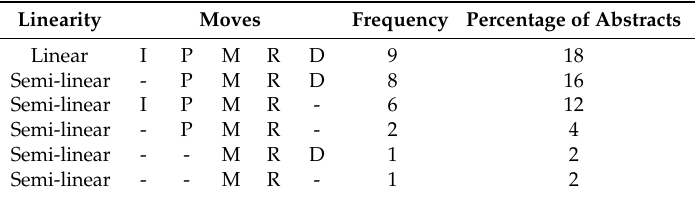
Table 5. Frequencies and percentages of linear and semi-linear patterns in 27 abstracts.